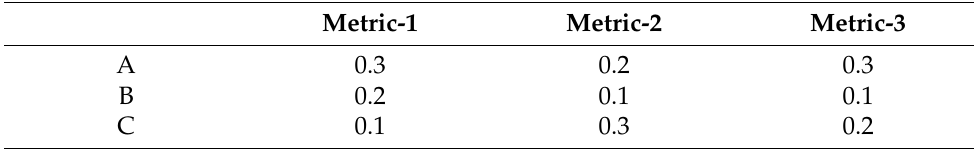
Table 3. An example of a simulation class importance